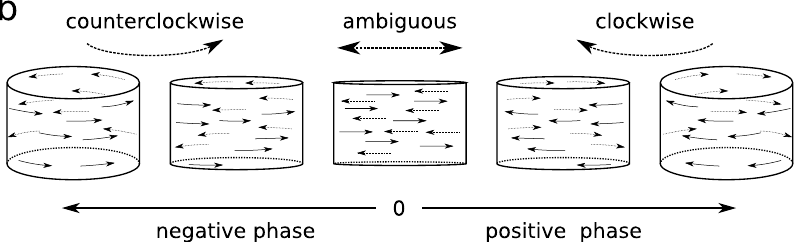
Figure 1. Stimuli. ( a ) The stimulus consists of 200 Gabor patches oscillating horizontally and presented dichoptically with different contrasts to each eye (here left eye 40%, right eye 80%). ( b ) The phase difference in the oscillation of the Gabor patches between the two eyes generates a percept of a motion-defined cylinder rotating in depth. If the phase difference is negative, the cylinder is seen rotating anticlockwise, with the front plane of the cylinder going to the right. If the phase difference is zero, the percept is ambiguous with Gabor patches moving to the left and to the right in the same plane. If it is positive the cylinder is seen rotating clockwise. Videos of a simplified version of the stimulus are available as supplementary